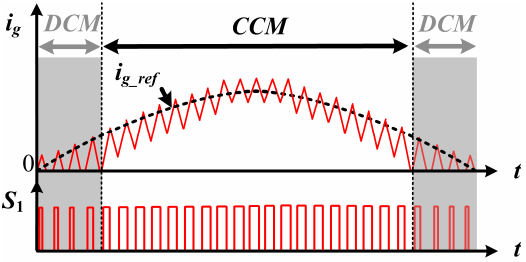
Figure 7. Operating modes depending on the grid current level during the positive grid voltage.